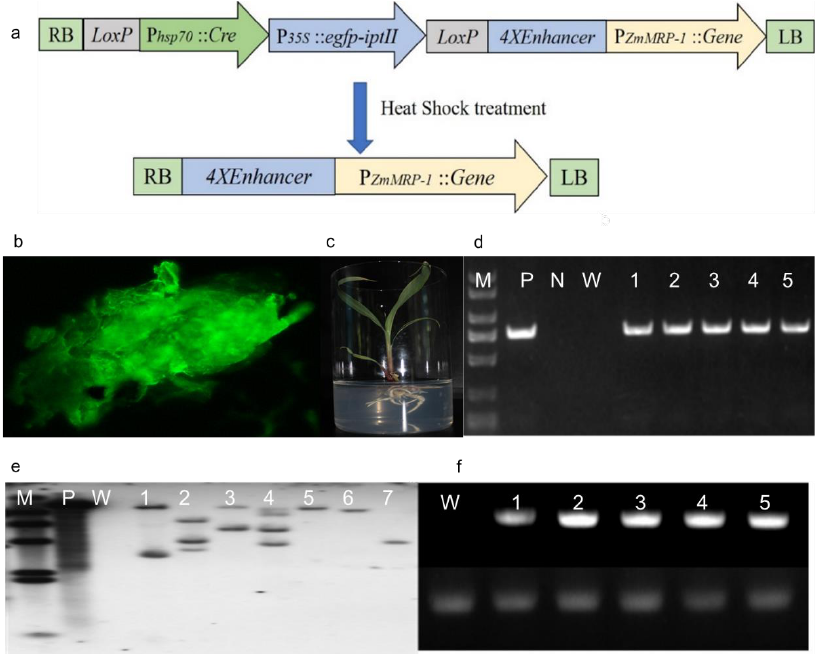
Figure 1. Preparation and detection of the trans-GS5 gene in maize. ( a ) Construction of transgenic vector pHZM1N-PZmMRP-1::GS5. The pHZM1N-Rsc vector was used as the backbone [44] to construct the transgenic vector. The rice GS5 vector expression cassette driven by the maize endo- sperm-specific promoter ZmMRP1 was used to replace the Rsc gene expression cassette driven by the ubi promoter in pHZM1N-Rsc to obtain the transgenic vector pHZM1N-PZmMRP-1::GS5. The vector was screened using the ipt-EGFP screening marker, and transgenic plants without the screening marker gene were obtained via differentiation after post-transformation heat-shock to eliminate the screening marker gene. ( b ) Screening of transgenic-positive calluses. Transgen- ic-positive calluses were screened using green fluorescent protein. ( c ) Obtaining marker-free transgenic plants. After heat shock to eliminate the screening markers, the transgenic calluses were differentiated to obtain normal transgenic plants, which were then transplanted to the greenhouse. trans-GS5- positive plants in the T 0 – T 2 generations according to the PCR results were then selected for harvest after selfing. ( d ) PCR assay of the GS5 gene of the T 3 generation of transgenic maize. M: DL2000 marker; molecular-weight standard, from top to bottom: 2 kb, 1.5 kb, 1.0 kb, 750 bp, 500 bp, 200 bp, and 100 bp; P: positive control; N: negative control; W: blank control; 1 – 5: transgenic sam- ples. ( e ) Southern blotting assay of the GS5 gene in the T 3 generation of transgenic plants. M: DNA HidIII marker; molecular-weight standard, from top to bottom: 23,130 bp, 9416 bp, 43,616,557 bp, 2322 bp, 2027 bp, and 564 bp; P: positive control; W: blank control; 1 – 7: transgenic samples. ( f ) RT-PCR results of the GS5 gene in the T 3 generation of transgenic plants. W: blank control; 1 – 5: